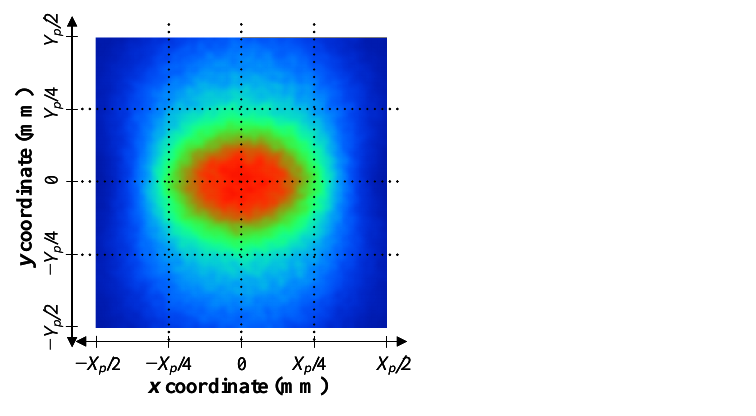
Figure 10. Hypothetical illuminance in the target plane of X P × Y P with 3 linear profiles on each